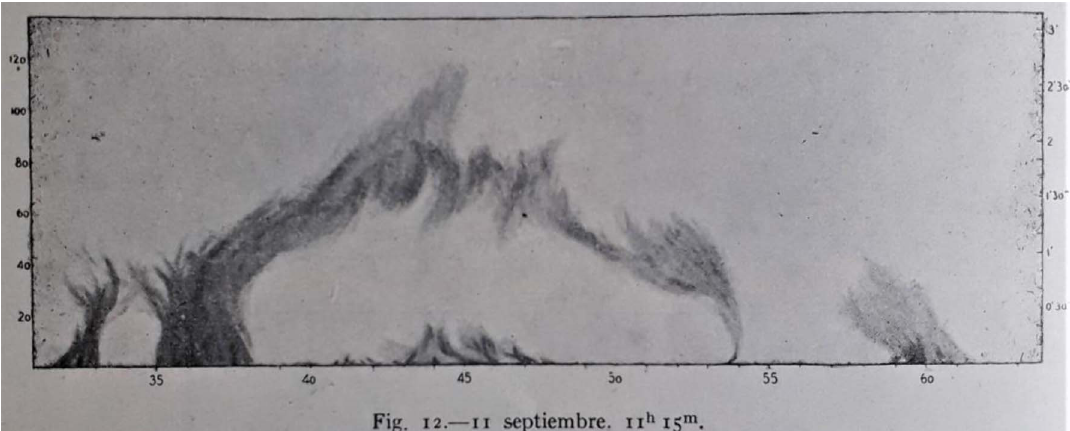
Figure 1. Solar prominence observed at the Madrid Astronomical Observatory on 11 September 1935. The heliographic latitude is shown along the abscissa, the height of the prominence in units of thousands of kilometers, and arcmin and arcsec are shown at left and right ordinates, respectively [Source: Gullón, 1936].